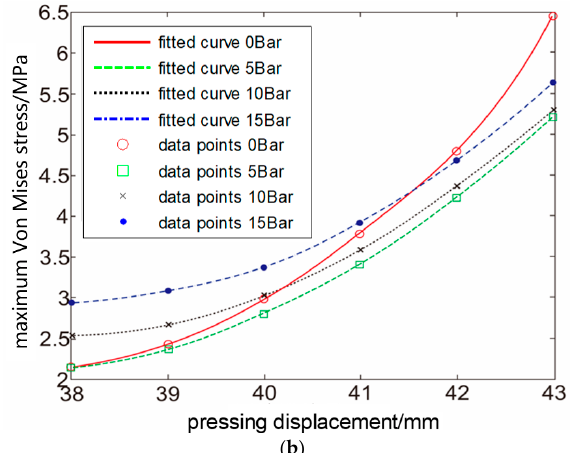
Table 4. Mathematical forms and goodness of fitting of the dependency of the counter force on the pressing displacement.